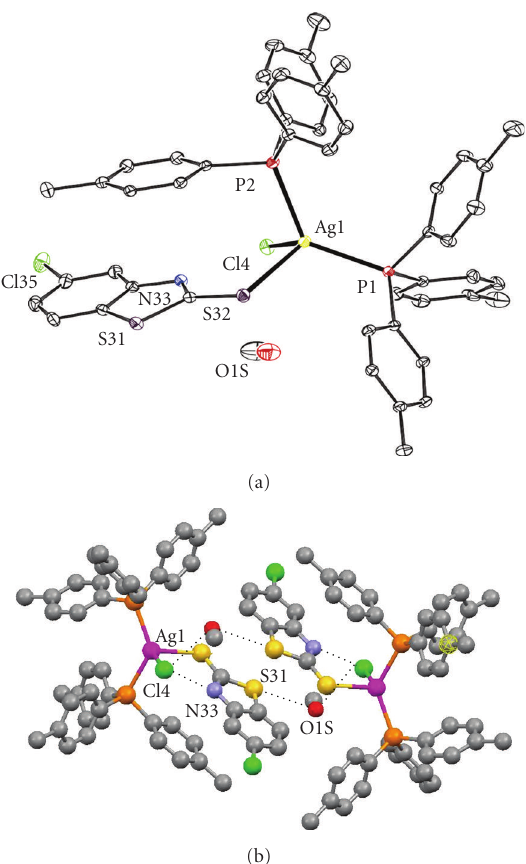
Figure 1: (a) ORTEP diagram of the crystal structure of complex 1 . (b) Intramolecular interactions (N33 ··· Cl4, S31 ··· O1S and O1S ··· Cl4) in 1 .